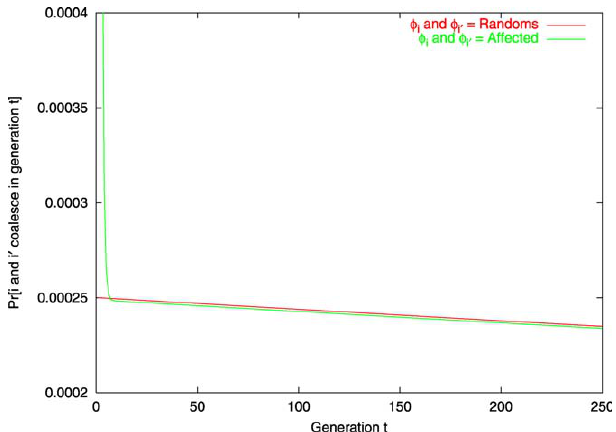
Figure 1. Coalescence Rates for Pairs of Random Chromosomes (Red) and for Pairs of Chromosomes from Affected Individuals (Green) Notice that chromosomes from affected individuals have a small excess probability of coalescing very rapidly (i.e., in the most recent ten generations or so). Otherwise, their coalescence rates are essentially like those of random chromosomes. The region at the left-hand side of the graph between the red and green lines represents the excess probability of very recent coalescence among case chromosomes (denoted R in the text). This is what gives rise to the effect of cryptic relatedness. For larger t, the line for cases drops slightly below the line for random individuals, since both distributions integrate to 1. These plots assume an additive genetic model, with k s ¼ 60, the ‘‘ half ’’ -relationships mating model, and a population size of 2,000. The line for cases was generated under the approximation that the excess relatedness is completely limited to the first n ¼ 10 generations. In this case, the maximum coalescent probability for case chromosomes is 0.00275, when t ¼ 1; R ’ 0.00334. As expected, the mean coalescence time is ’ 4,000 generations for both distributions. Alterations in n yield similar results (unpublished data). DOI: